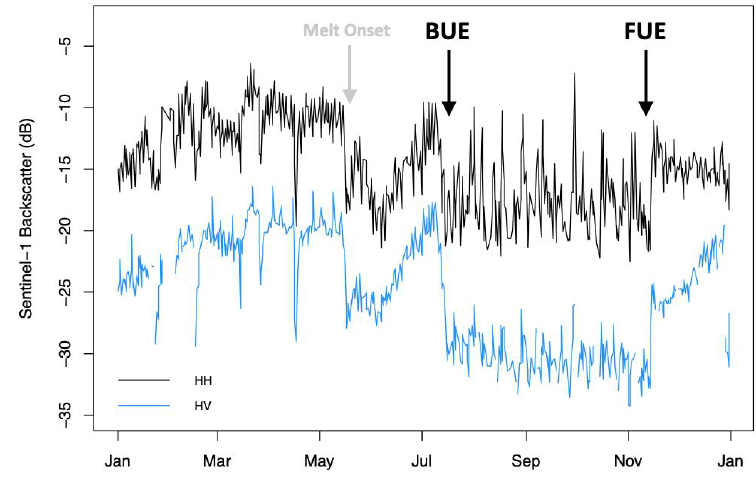
Figure 5. Example time series of lake-wide average Sentinel-1 backscatter from 2015. The black line shows the backscatter at HH polarization, while the blue line is for HV polarization. The sharp drop in backscatter in mid-May indicates the onset of melting of the snow and ice on the lake (melt onset), while the sharp drop in early July marks the disappearance of ice (BUE). In this particular year, a sharp increase in backscatter was observed in early November, which also marks a change in the variability of the backscatter time series. This is taken to be the date at which the lake froze over (FUE). However, in some years, this transition was gradual and only identifiable by the change in backscatter variability.